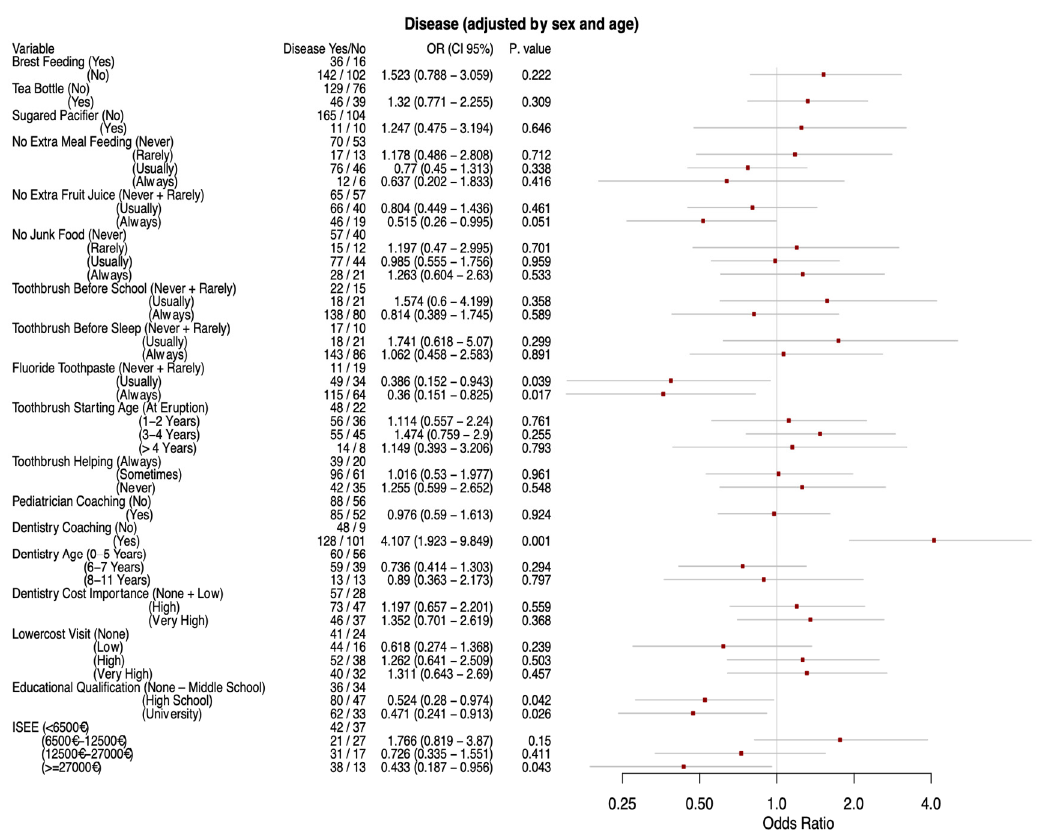
Figure 1. Multivariate unconditional logistic regression analysis for the outcome disease adjusted by sex and age.